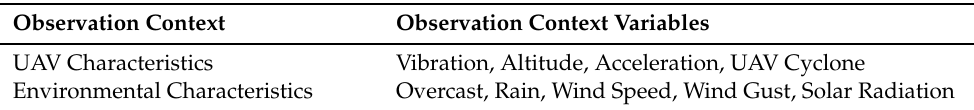
Table 2. Observation contexts and related